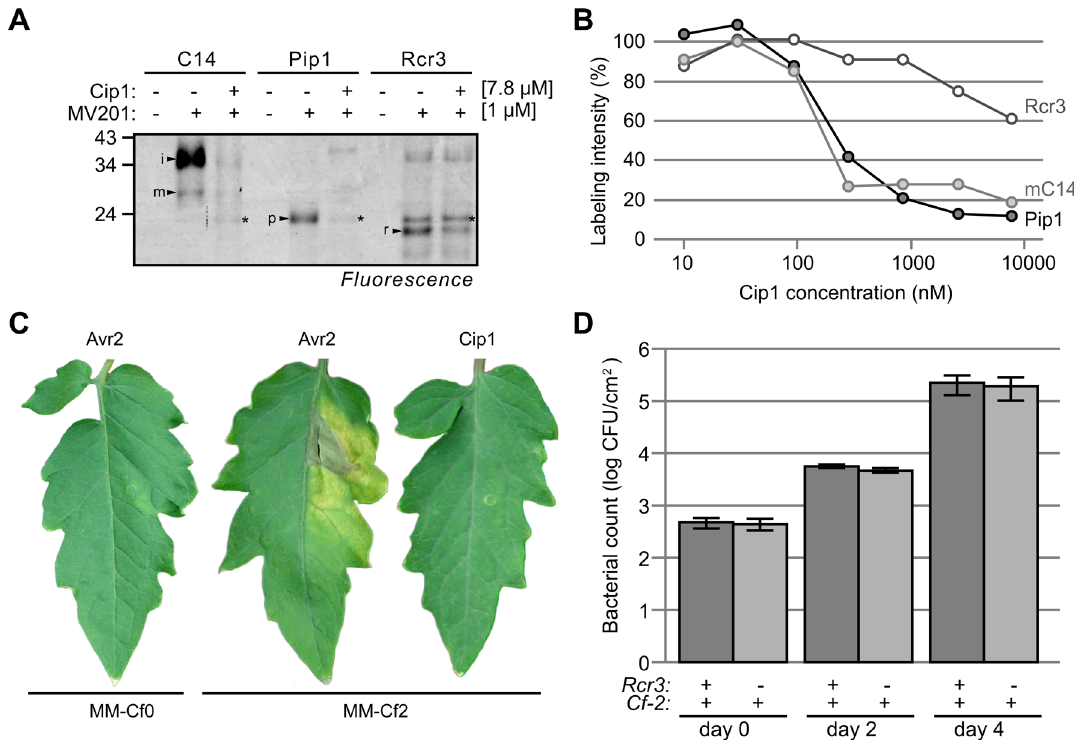
Fig 8. Cip1 blocks all three immune proteases of tomato with different affinities and escapes recognition by Rcr3/ Cf-2. (A) Cip1 suppresses active site labeling of C14, Pip1 and Rcr3. Extracts containing the proteases were pre-incubated with 7.8 μ M Cip1 and then labeled with MV201, a fluorescent probe for PLCPs. * , endogenously biotinylated protein. Abbreviations: i, iC14; m, mC14; p, Pip1; r, Rcr3. (B) Cip1 has highest affinity for Pip1 and C14. Extracts containing the proteases were pre-incubated with various concentration of Cip1 and then labeled with MV201. Labeled proteins were quantified from gel and plotted against the Cip1 concentration. (A-B) C14, Pip1 and Rcr3 were transiently overexpressed by agroinfiltration and proteomes were isolated and pre-incubated with and without various concentrations of Cip1 at pH 6.2 for 30 minutes and then labeled with 1 μ M MV201 for one hour. Labeled proteins were detected by in-gel fluorescence scanning. (C) Cip1 does not trigger hypersensitive cell death in Cf2/Rcr3 tomato plants. 100 nM Avr2 or 1 μ M Cip1 were injected into leaflets of MM-Cf2 and MM-Cf0 tomato plants and photographs were taken five days after the injection. (D) The presence of Rcr3 does not affect bacterial growth of PtoDC3000. Cf2/Rcr3 and Cf2/rcr3-3 tomato plants were spray- inoculated with PtoDC3000 and the bacterial populations were determined at 0, 2 and 4 days-post-inoculation. Error pars represent SEM for n = 4 different leaf samples taken during the same assay. This experiment was repeated four times with similar